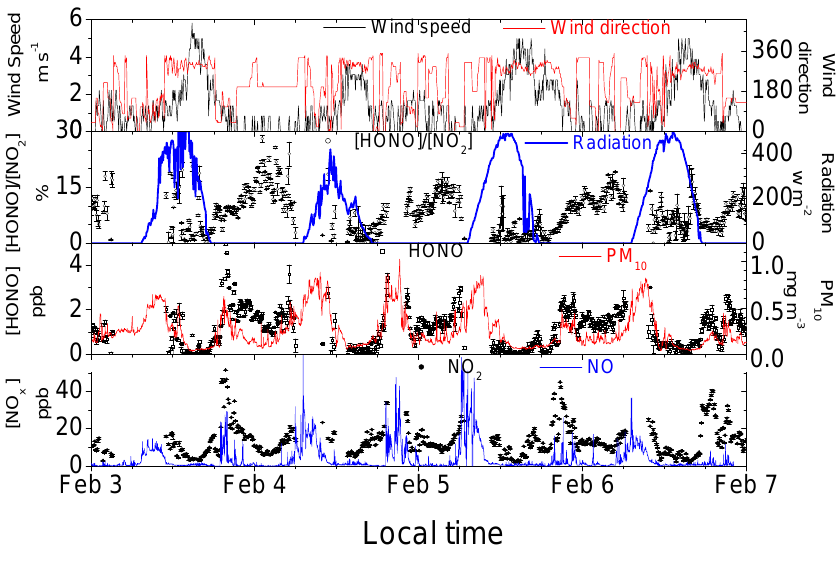
Figure 3. Behavior of [NO 2 ], [HONO], [HONO] / [NO 2 ], PM 10 , and meteorological parameters (wind speed, wind direction, and solar radiation) during February 3-7 in Kathmandu urban air. The error bars are 1 σ standard deviation.